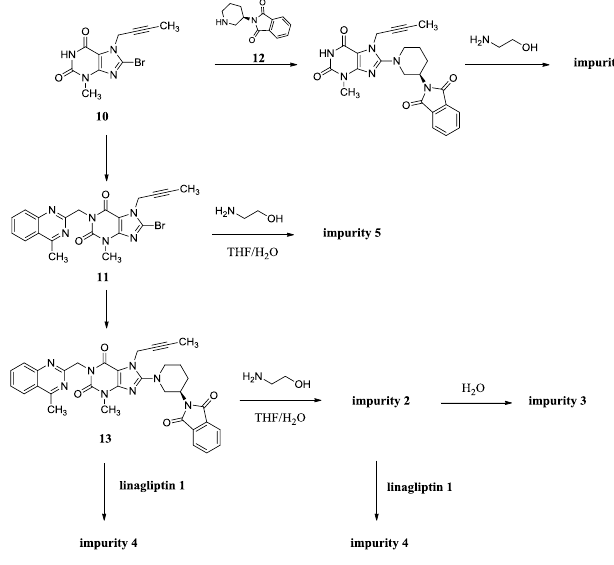
Scheme 2. Source of impurities of linagliptin.